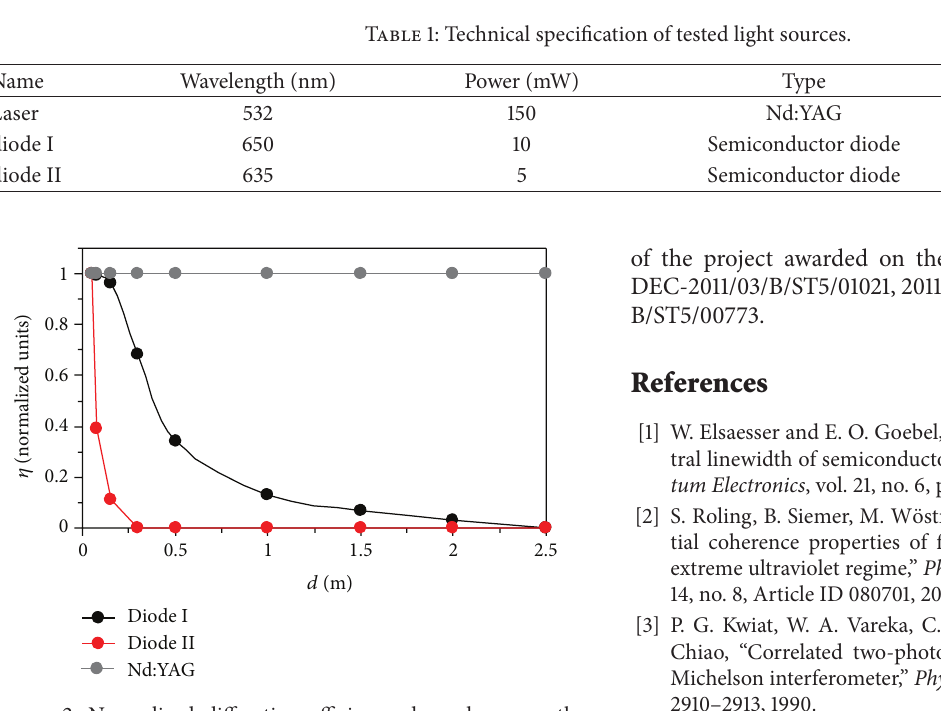
Figure 2: Normalized diffraction efficiency dependence on the optical paths difference of a self-interfering laser beam for tested coherent light